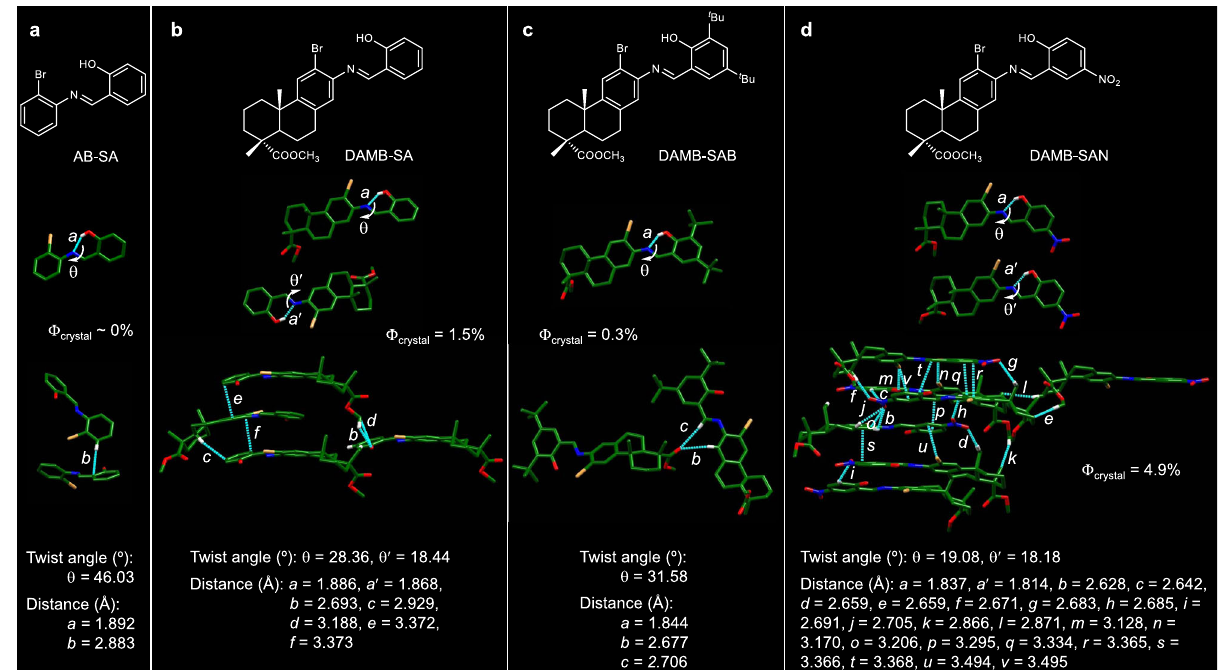
Fig. 3 Single crystal structure and crystal packing. Chemical structures (top), single crystal structures (middle), and their respective intermolecular interactions (bottom) of a AB-SA, b DAMB-SA, c DAMB-SAB, and d DAMB-SAN.